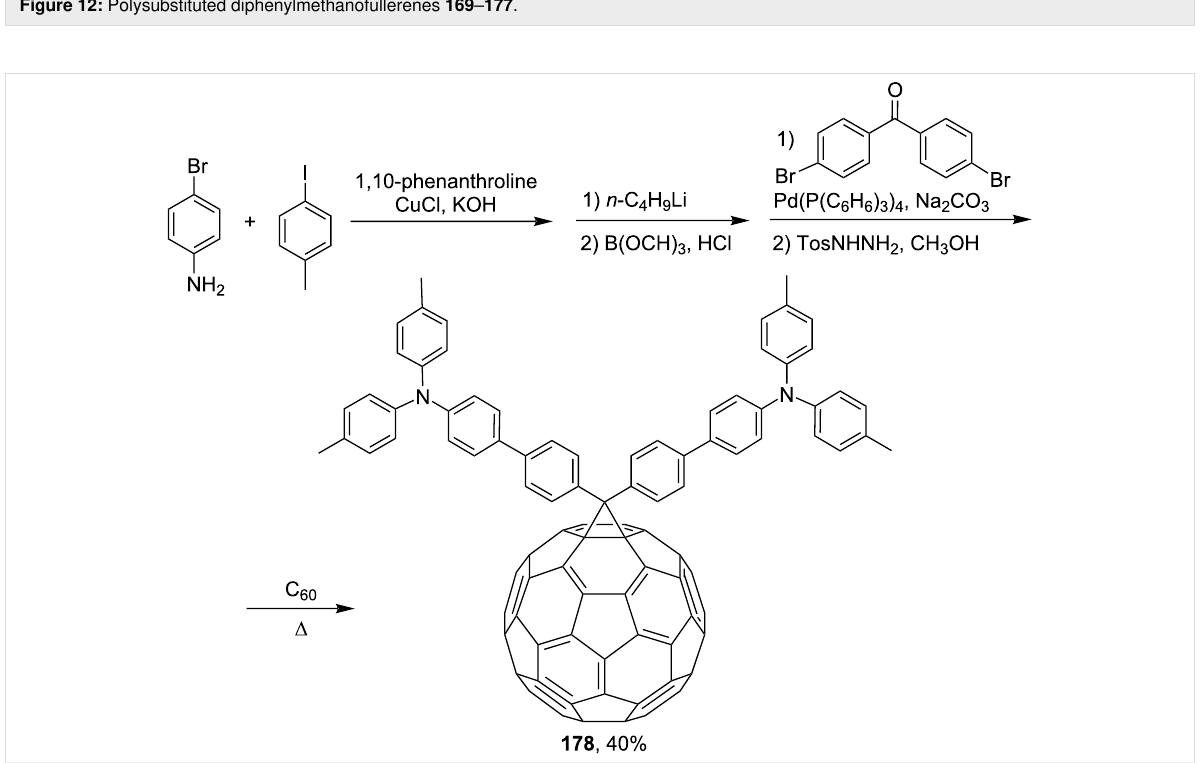
Scheme 30: The synthetic route to triphenylamine-substituted methanofullerene 178